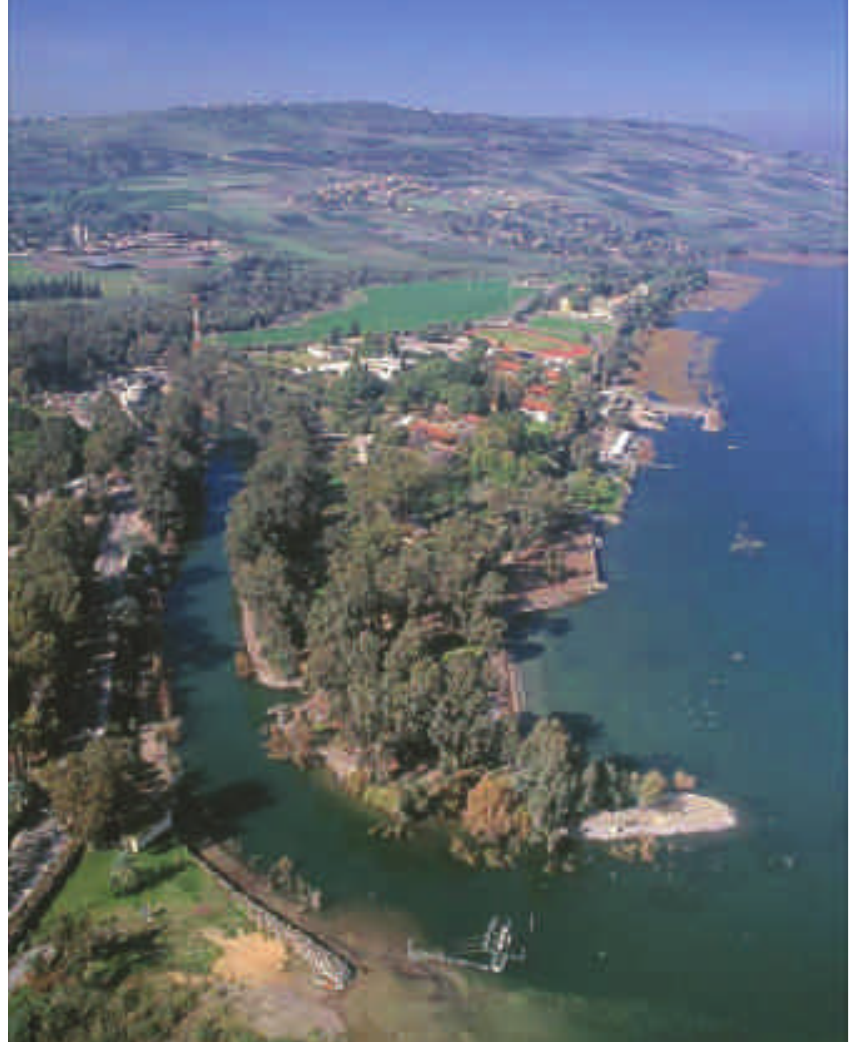
Figure 1 Tel Bet Yerah (Khirbet el-Kerak), by the Sea of